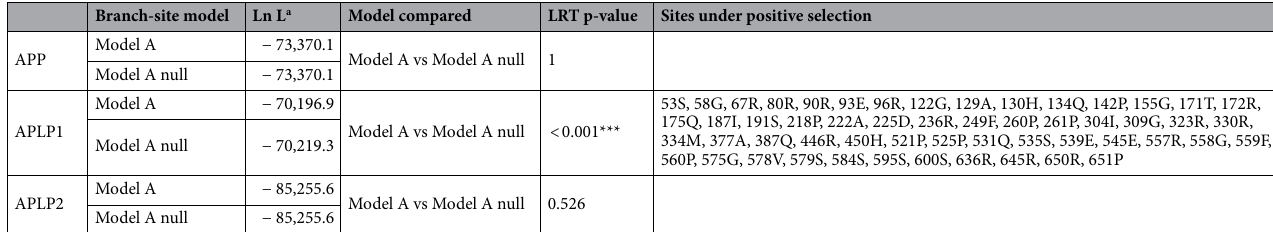
Table 1. Branch-site model applied to each stem branch of mammalian clade (*** p-value < 0.01; p-values are derived from likelihood ratio tests under test statistic 2Δℓ following χ 2 distribution). a Log